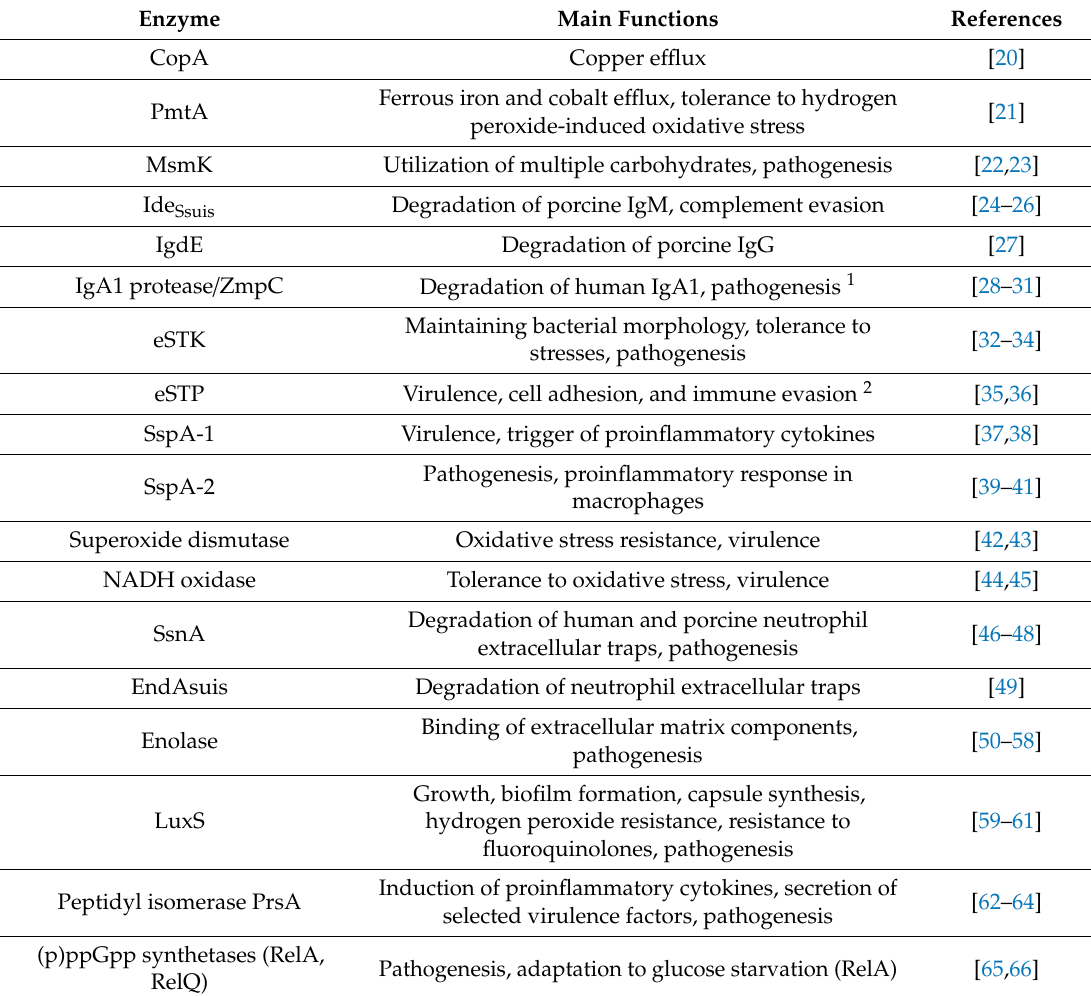
Table 1. Characterization of some representative enzymes in Streptococcus suis . Main